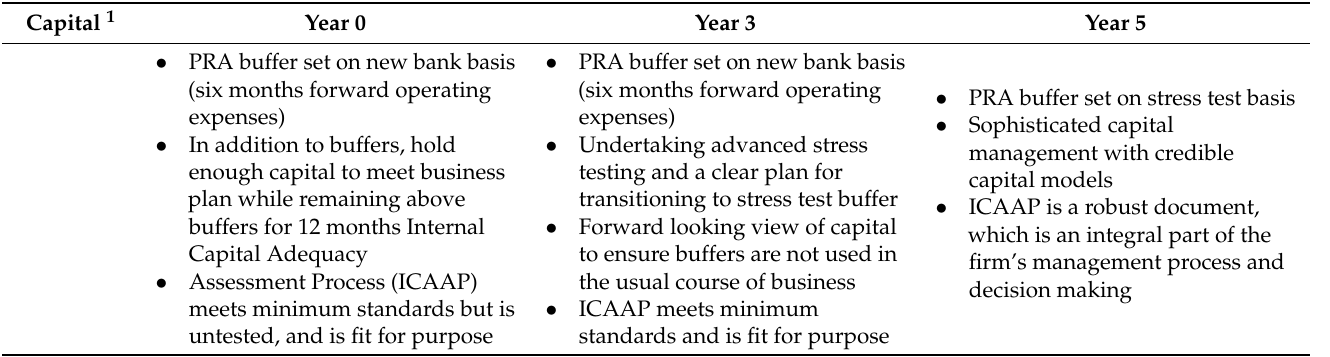
Table 1. PRA’s ICAAP